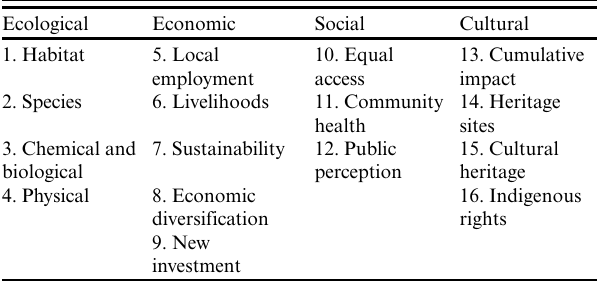
Table 1 . Southwest New Brunswick Marine Advisory Committee Community Values Criteria (MRPD Steering Committee 2009).